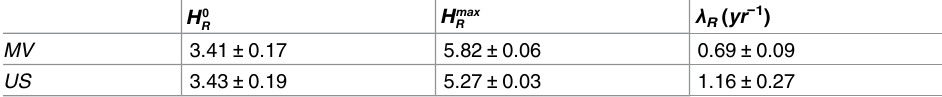
Table 1. Optimal parameters for the model of gut microbiome NRAD entropy as function of age.